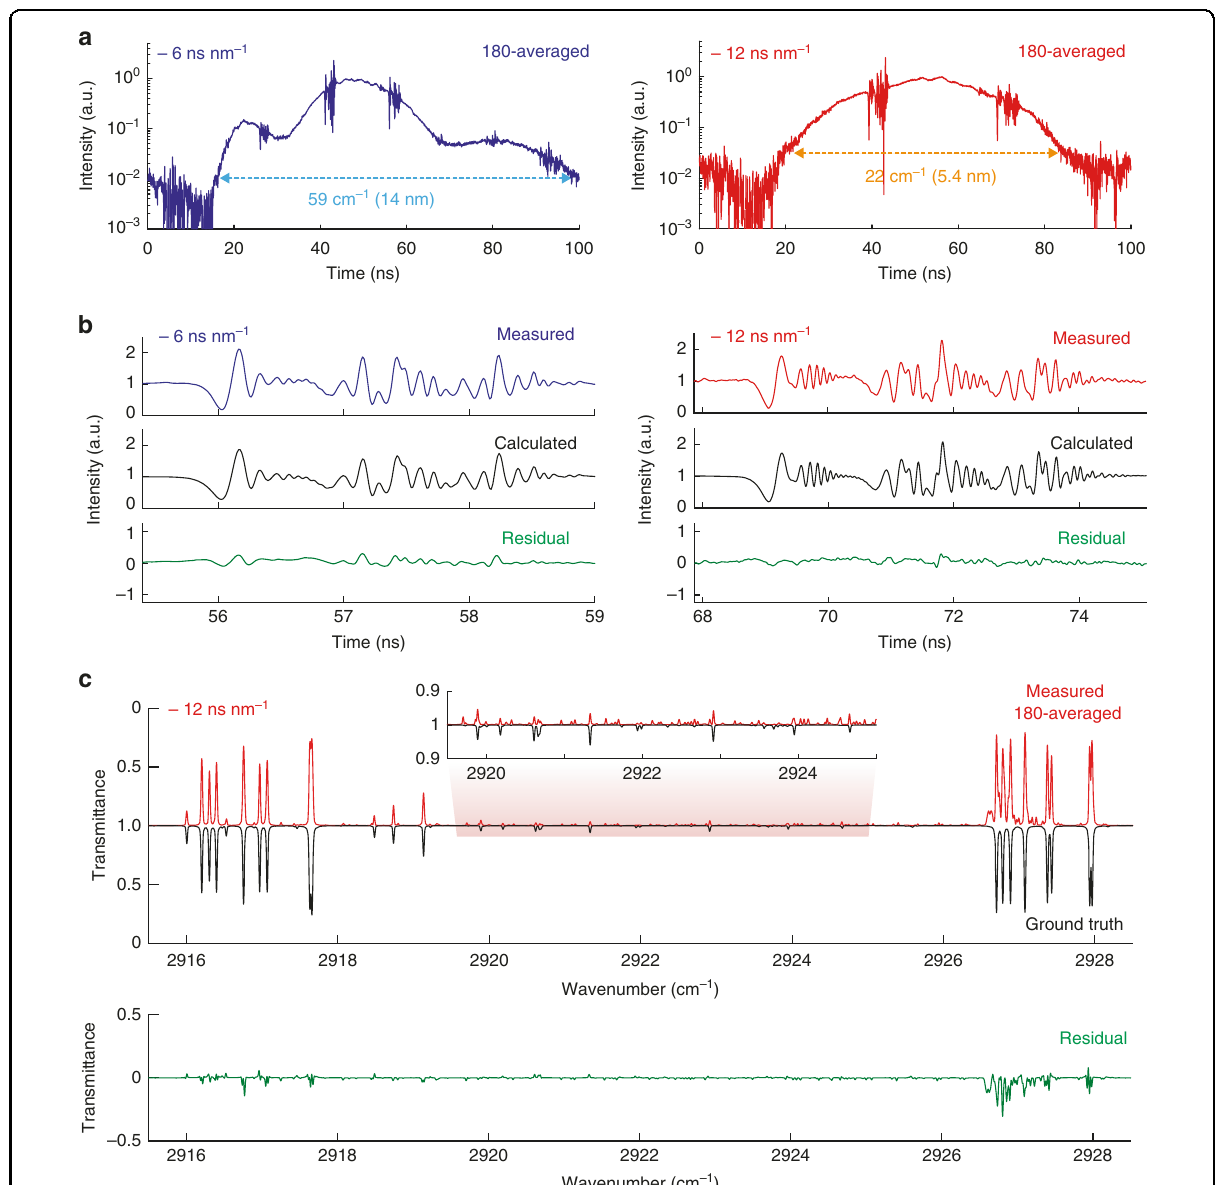
Fig. 4 High-resolution broadband TSIR spectra of CH 4 molecules. a 180-times averaged TSIR spectra measured with a 30-km DCF (dispersion of − 6 ns nm − 1 ) (blue) and a 60-km DCF (dispersion of − 12 ns nm − 1 ) (red). b Comparison between a part of measured and calculated TSIR spectra. The temporal baselines of the measured TSIR spectra are normalized by the envelope functions. The green plots represent the residuals. c A retrieved transmittance spectrum (dispersion of − 12 ns nm − 1 ) by the GD algorithm (red) compared to a calculated ground-truth transmittance spectrum from the HITRAN database (black). The inset shows a zoom-in view of small absorption peaks. The green plot shows